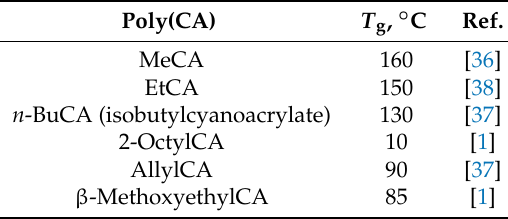
Table 2. Glass transition temperatures ( T g ) of